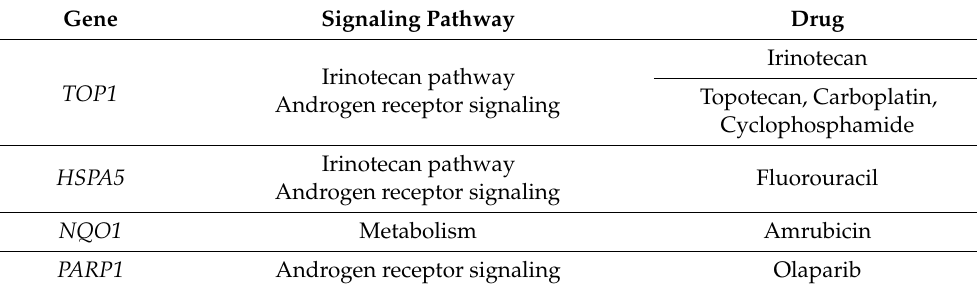
Table 2. Actionable drug list and targeted gene.